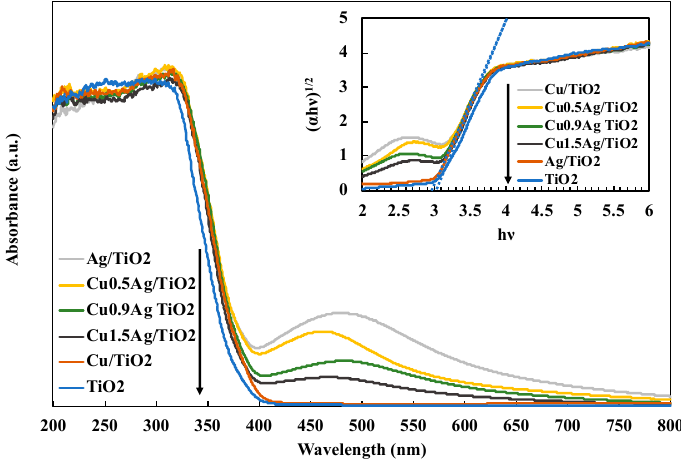
Figure 4. DRS spectra of various TiO 2 samples.